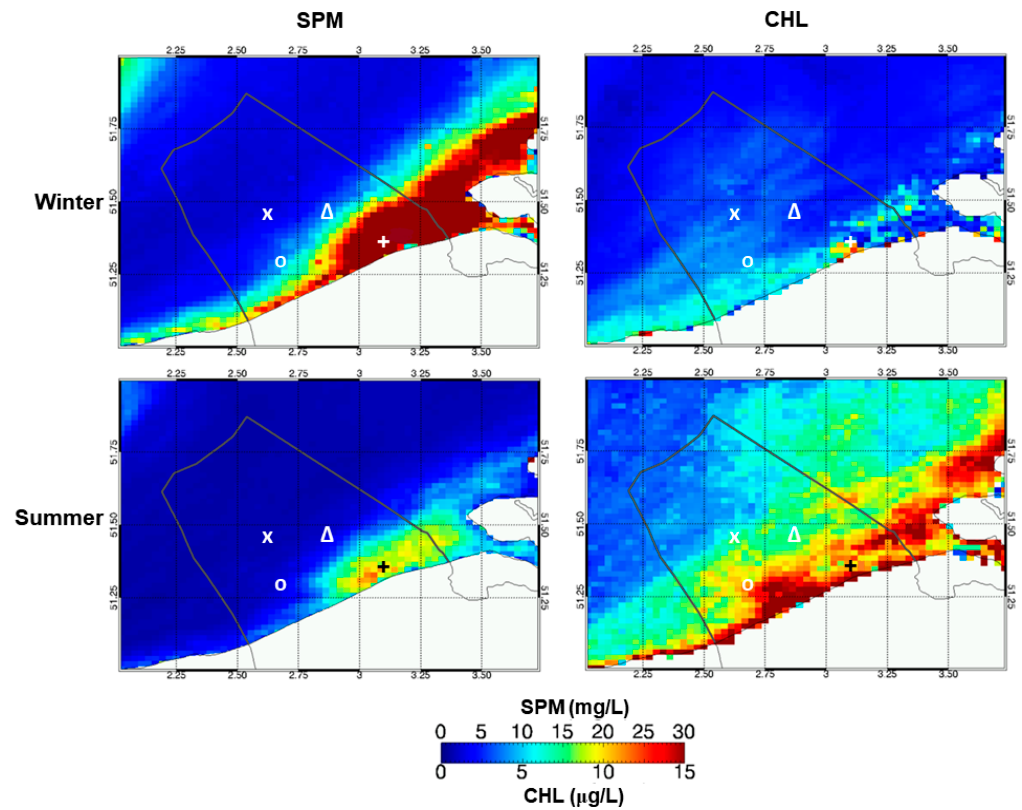
Figure 1. Mean surface suspended particulate matter (SPM) and chlorophyll-a (CHL) concentrations in the southern North Sea during the winter (October–March, top) and summer season (April–September, bottom) derived from the MERIS satellite. The +, ∆ , X, and O symbols indicate the measurement sites of MOW1, Gootebank (G-Bank), Hilnderbank (H-Bank), and Kwintebank (K-Bank), respectively. Turbidity maximum zone (TMZ) has SPM concentrations above 15–20 mg/L and the offshore zone (OSZ) below 10 mg/L.